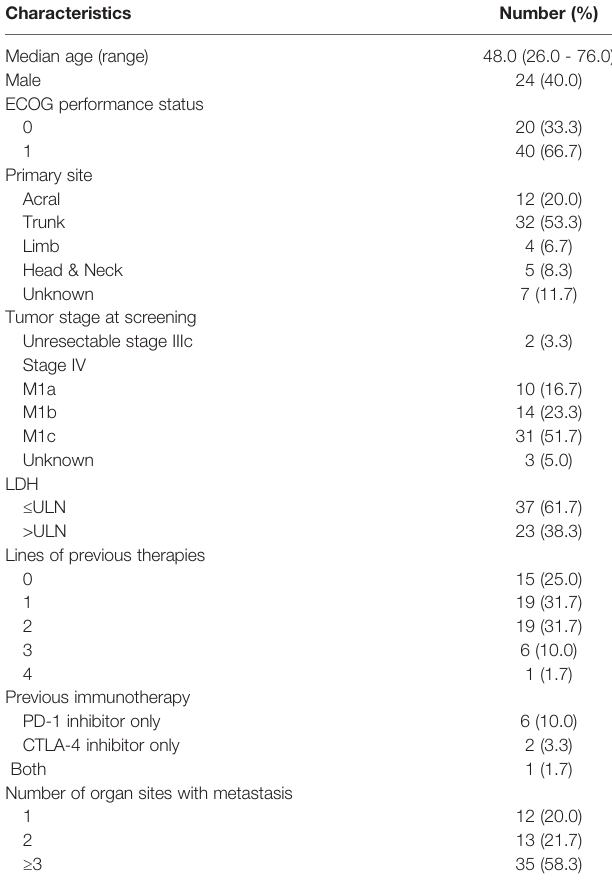
TABLE 1 | Baseline characteristics of the